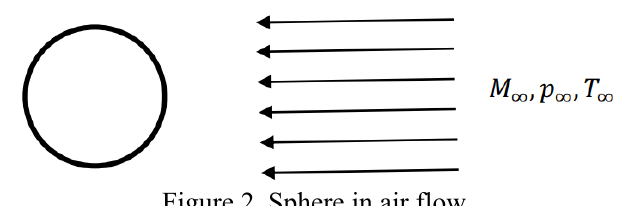
Figure 2. Sphere in air flow